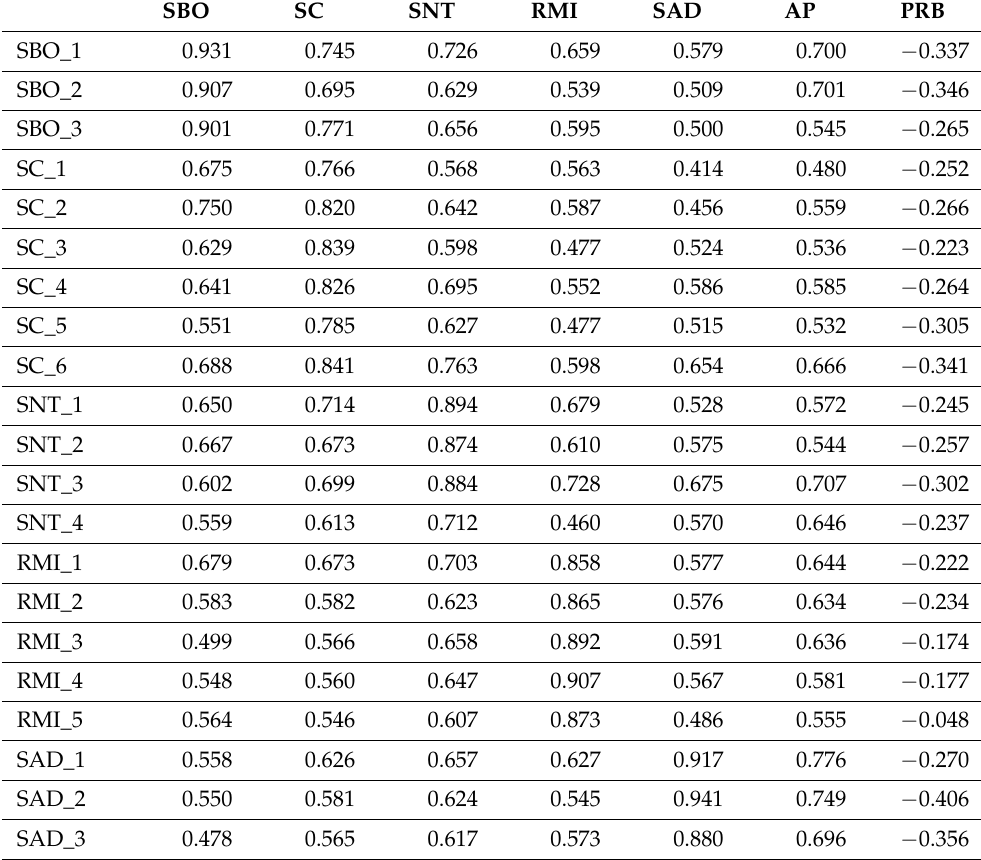
Table 2. Cross-loading